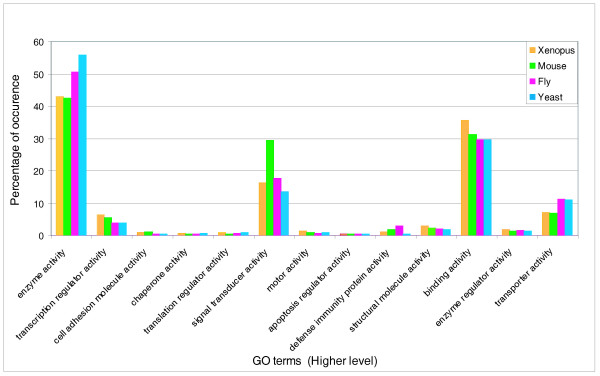
Comparison of GO slims between Xenopus, fly, yeast and mouse: Distributions of higher-level GO terms (,,GO slim", see text) for Xenopus, fly, yeast and mouse. The sum of all high-level terms may exceed the total number of the annotated terms, since some terms may have more than one high-level "parent" terms due to multiple paths.